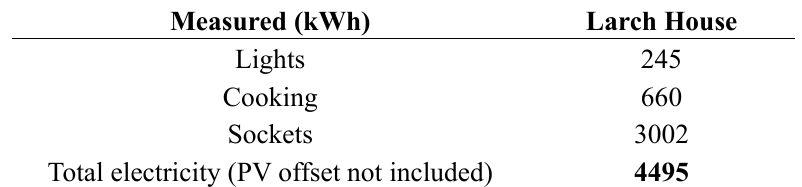
Table 2. Annual average electricity use from two years of Larch House